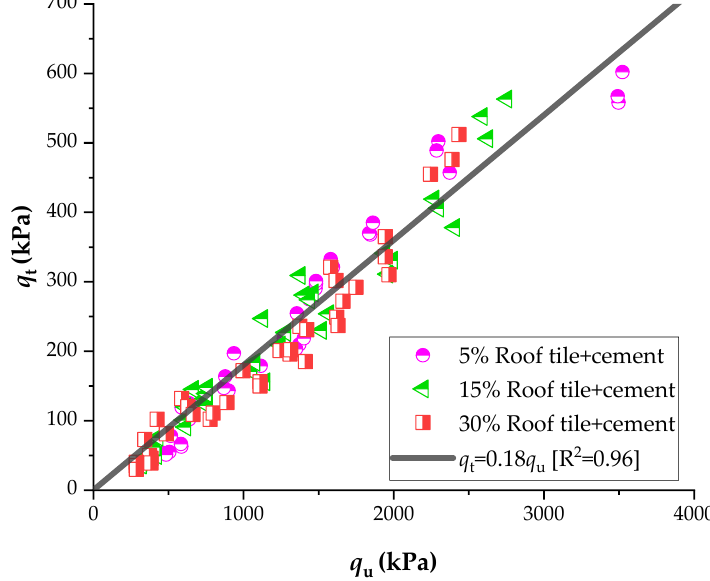
Figure 6. Direct empirical relationship between the tensile and compressive strength for all specimens’ tests, using different dry unit weights, cement content and roof tile waste.